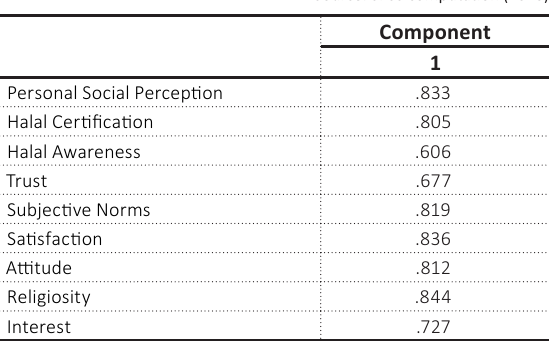
Figure 2. shows the Eigenvalues values following Table 4, i.e., only one component has a value > 1. Table 5. Component matrix a